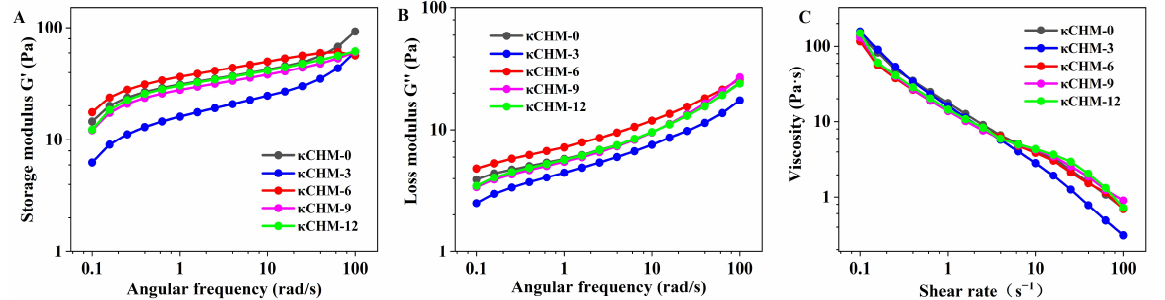
Figure 1. Dynamic rheological properties of κCHM film-forming solutions. ( A ) Storage modulus G′, ( B ) loss modulus G″ and ( C ) viscosity of film-forming solutions.